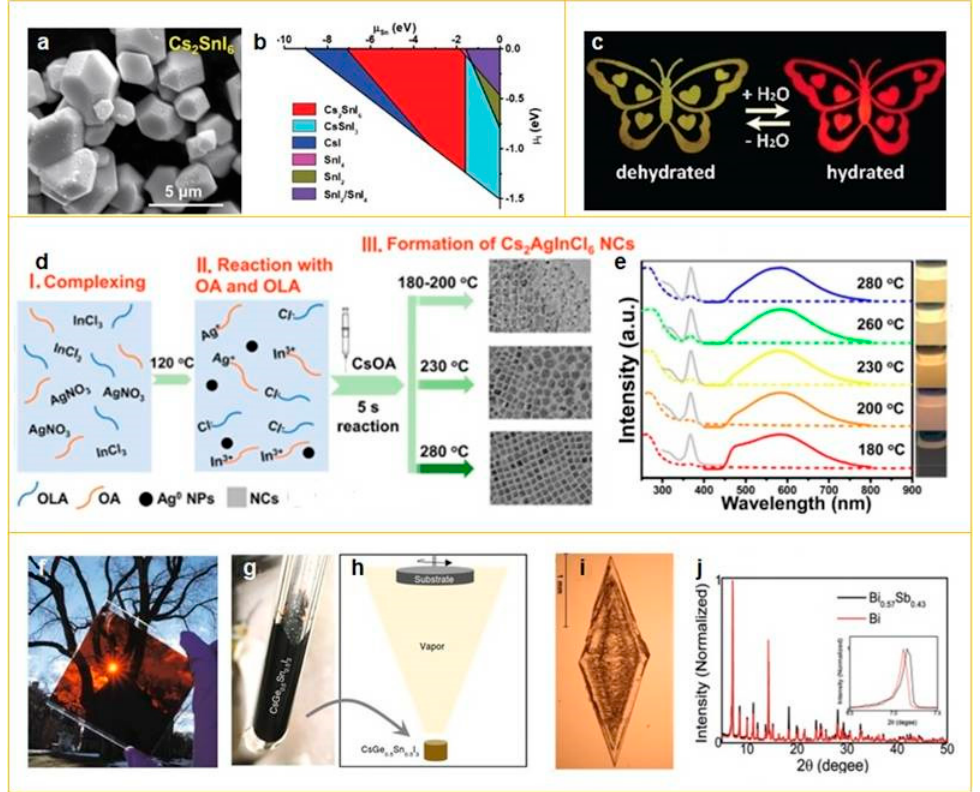
Figure 2. Synthesis of lead-free perovskites. ( a ) SEM images of Cs 2 SnI 6 ; ( b ) calculated phase diagram of Cs–Sn–I. Reproduced with permission [31]. Copyright WILEY-VCH Verlag, GmbH & Co. KGaA, Weinheim, Germany, 2019. ( c ) Visualized dual emission between the hydrated and dehydrated species, fabricated by embedding the perovskite material, Cs 2 InBr 5 · H 2 O into an etched butterfly pattern. Reproduced with permission [34]. Copyright WILEY-VCH Verlag, GmbH & Co. KGaA, Weinheim, Germany, 2018. ( d ) Schematic representation on the phase formation of Cs 2 AgInCl 6 :Bi NCs at di ff erent synthesis temperatures (180–280 ◦ C) in three steps: (I) Complexing of optimized precursors including OA, OlAm, and HCl; (II) AgNO 3 and InCl 3 reacting with OA to form Ag − oleate and In − oleate and oleylammonium chlorine. Ag 0 NPs are formed by the reduction of Ag + in the presence of amine ligands; (III) formation of Cs 2 AgInCl 6 NCs at di ff erent synthesis temperatures followed by the injection of CsOA; ( e ) UV − Vis absorption (dashed line), photoluminescence (PL) (excitation at 368 nm), and PL excitation (emission at 580 nm) spectra of Bi-doped Cs 2 AgInCl 6 NCs dispersion in hexane obtained at di ff erent synthesis temperatures (180–280 ◦ C); the insets show the samples irradiated under a 365 nm UV lamp. Reproduced with permission [45]. Copyright American Chemical Society, 2019. ( f ) Photograph of an as-synthesized large-area CsSn 0.5 Ge 0.5 I 3 perovskite thin film on a glass substrate showing dark reddish color. ( g ) Photograph of as-synthesized CsSn 0.5 Ge 0.5 I 3 perovskite solid using the melt-crystallization method. ( h ) Schematic illustration of the single-source evaporation method for the deposition of ultrasmooth CsSn 0.5 Ge 0.5 I 3 perovskite thin film. Reproduced with permission [56] Copyright Springer Nature Limited, 2019. ( i ) Image of (C 8 NH 12 ) 4 Bi 0.57 Sb 0.43 Br 7 · H 2 O single crystal. ( j ) Powder